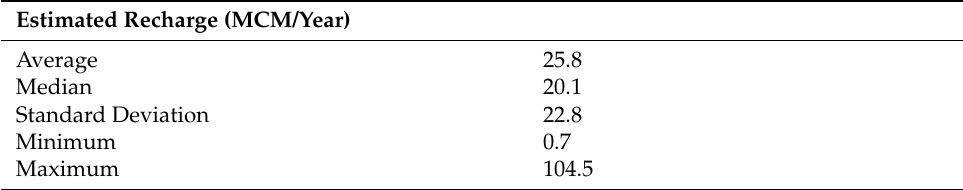
Table 2. The 1954–2020 estimated recharge in the